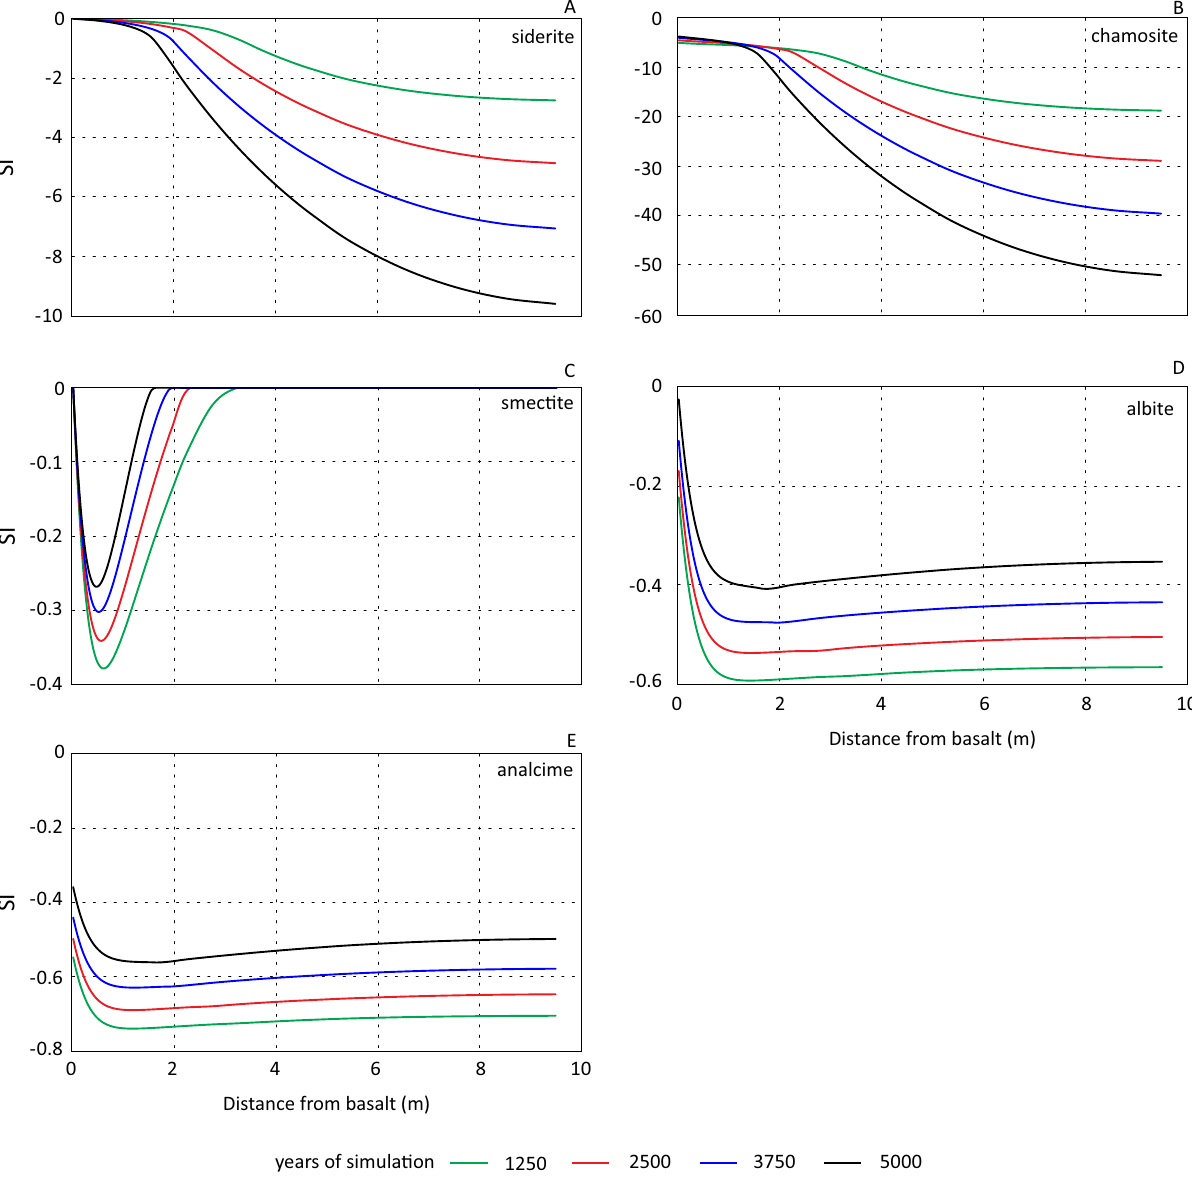
Figure 10. Temporal and spatial evolution of saturation index (SI) siderite ( A ), chlorite (chamosite) ( B ), smectite ( C ), albite ( D ) and analcime ( E